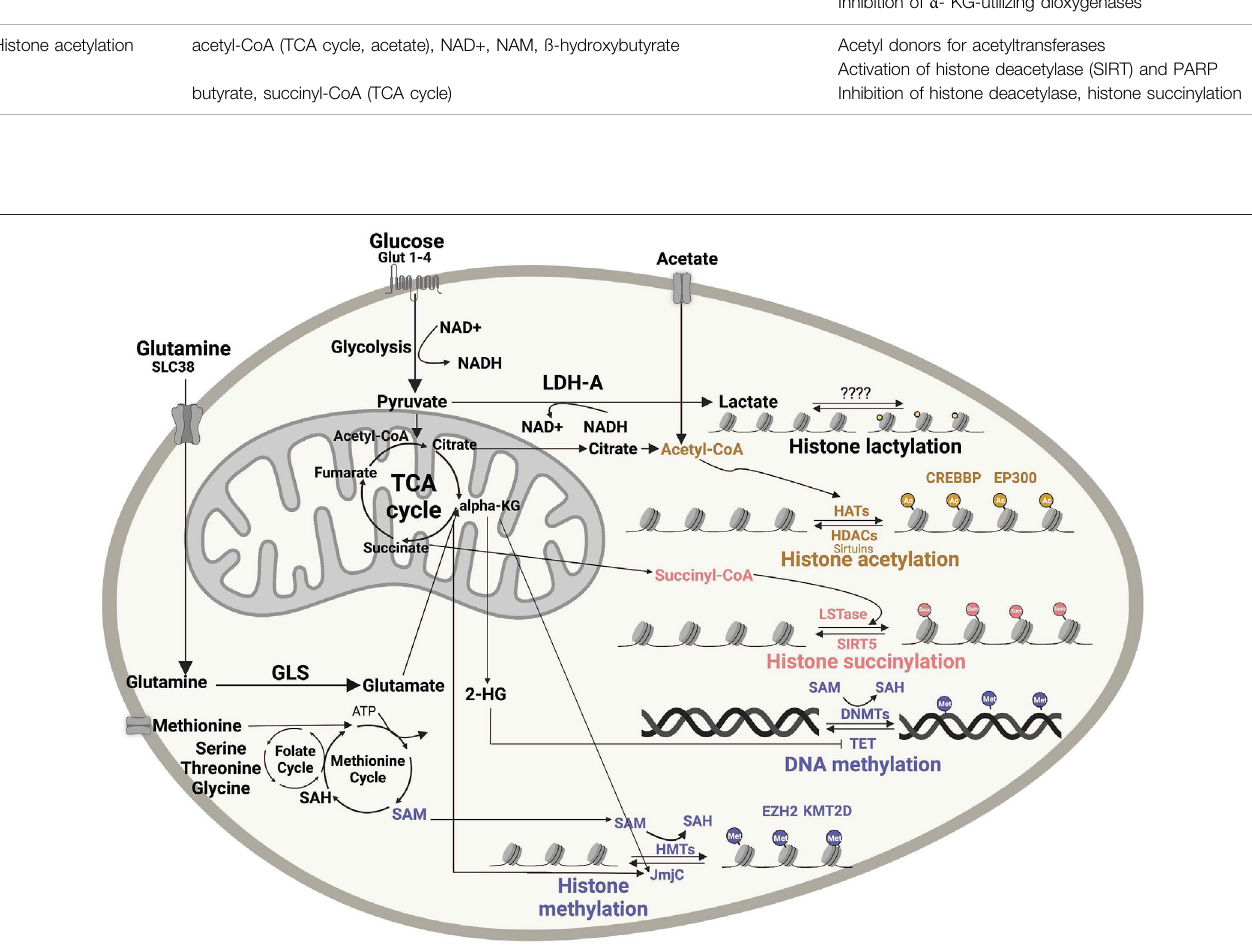
Frontiers in Cell and Developmental Biology |